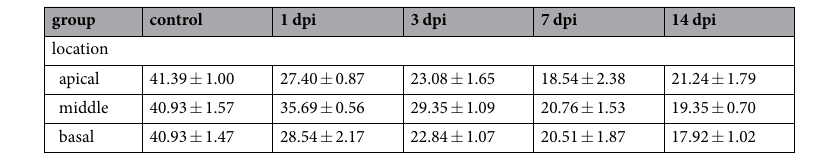
Table 1. Between-group comparison on SGN density. N > 5 for each group. The SGN density is measured as the SGN#/10000 nm 3 . The density measured in Cre + group at every time point after DT injection was significantly lower than the control value at each location (p <